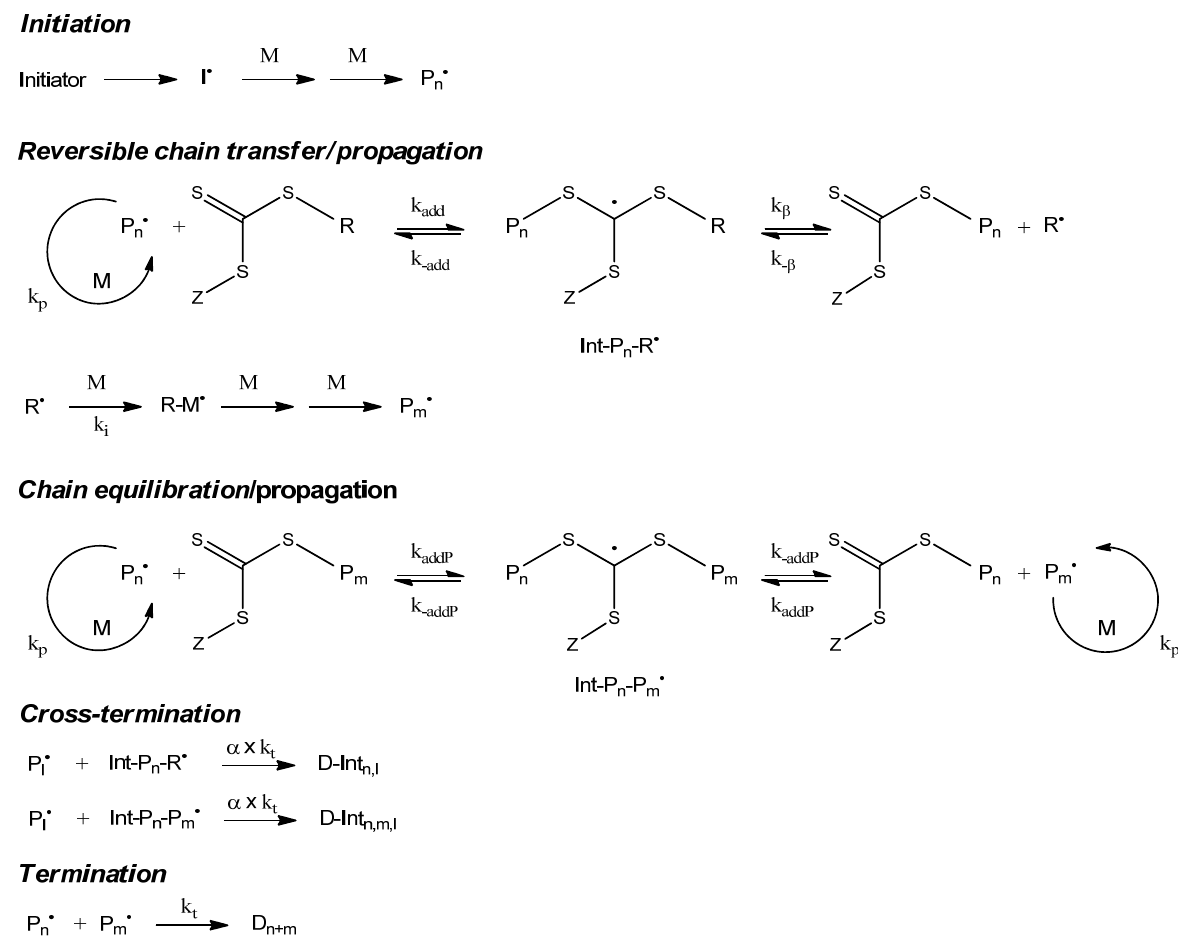
Figure 10. Kinetic model of reversible addition fragmentation chain